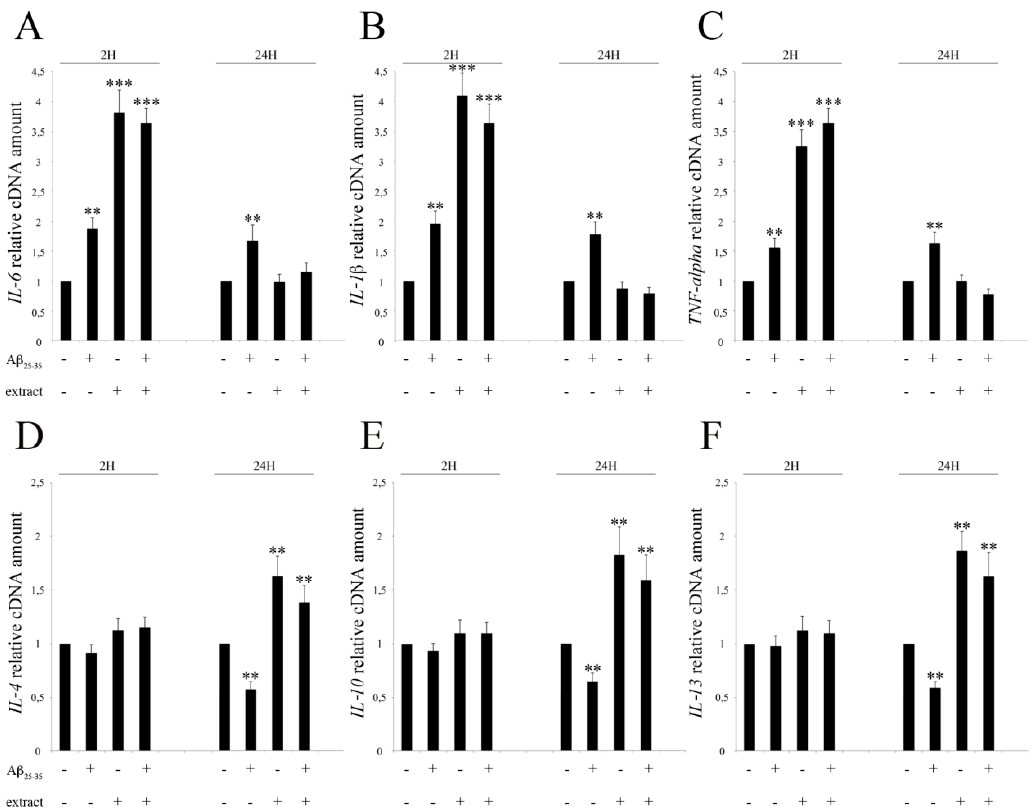
Figure 2. Modulation of pro-inflammatory and anti-inflammatory cytokines in BV2 cells treated with 25 µ M A β 25–35 and/or 20 µ L/mL of EtOAc extract, evaluated by qRT-PCR at 2 and 24 h. ( A ) IL-6 expression; ( B ) IL-1 β expression; ( C ) TNF- α expression; ( D ) IL-4 expression; ( E ) IL-10 expression; ( F ) IL-13 expression. Data are shown as mean ± SEM ( n = 3). ** p < 0.01 vs. Ctrl; *** p < 0.001 vs. Ctrl.